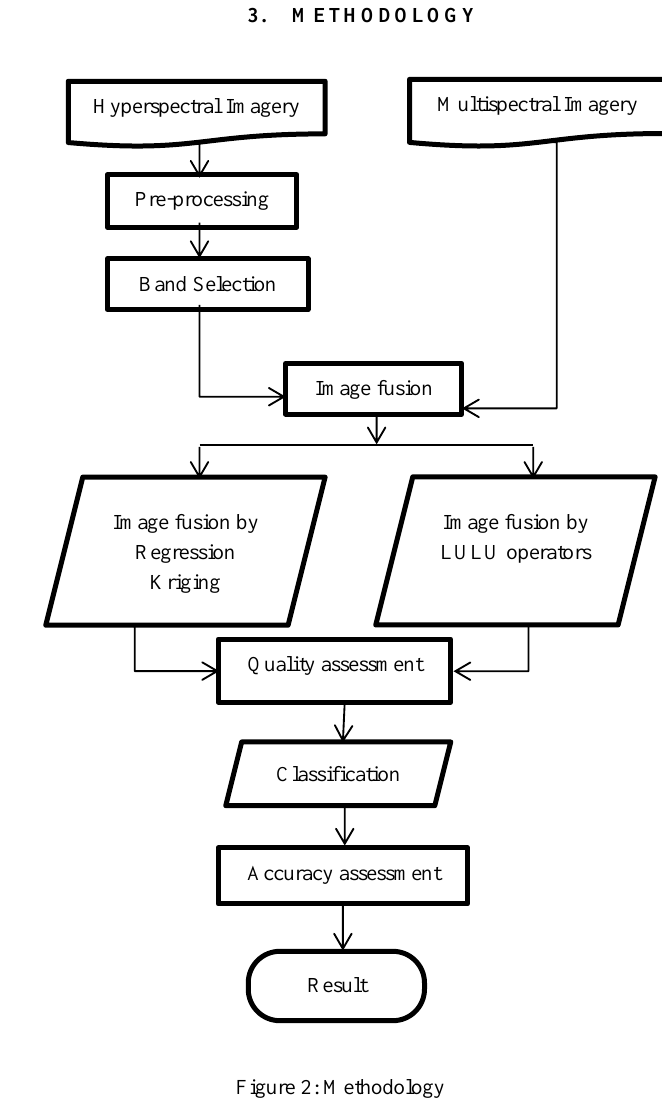
Figure 2: Methodology Regression